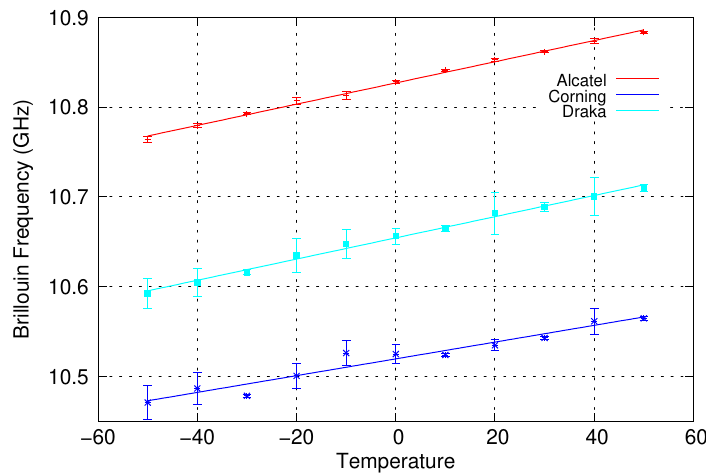
Figure 6. Variation of bare fibres Brillouin frequency with temperature.